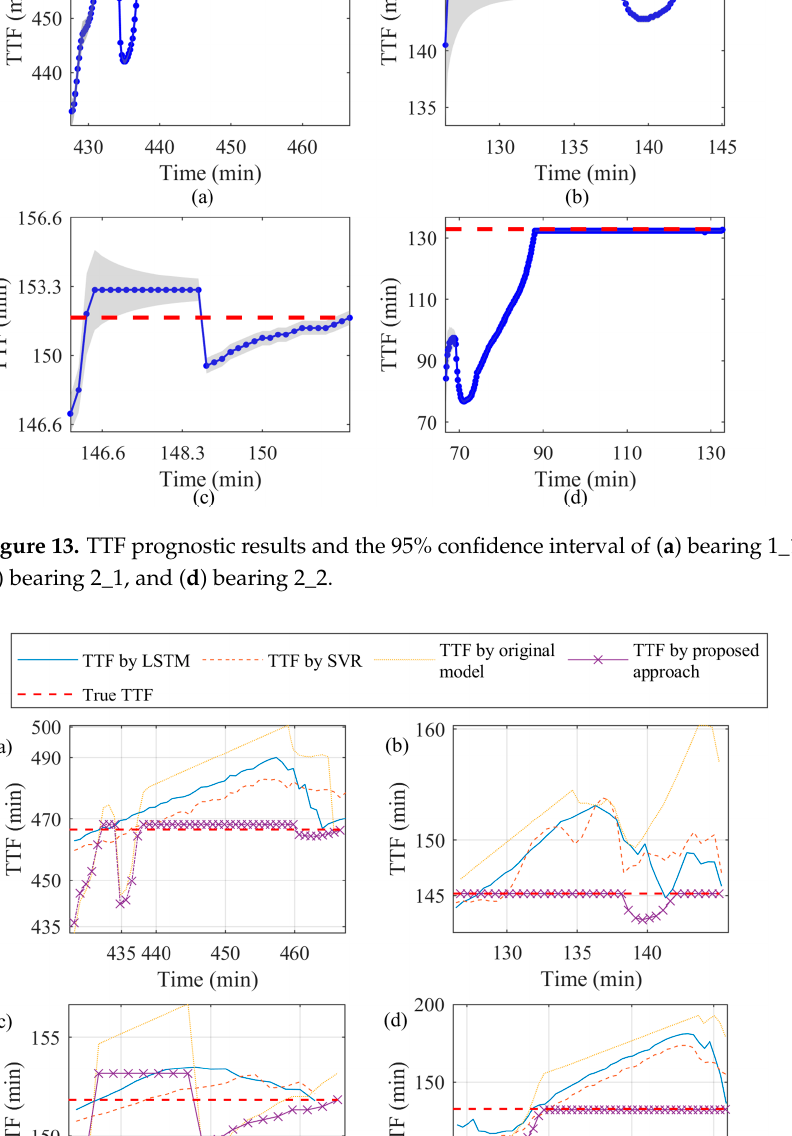
Figure 13. TTF prognostic results and the 95% confidence interval of ( a ) bearing 1_1, ( b ) bearing 1_2, ( c ) bearing 2_1, and ( d ) bearing 2_2.